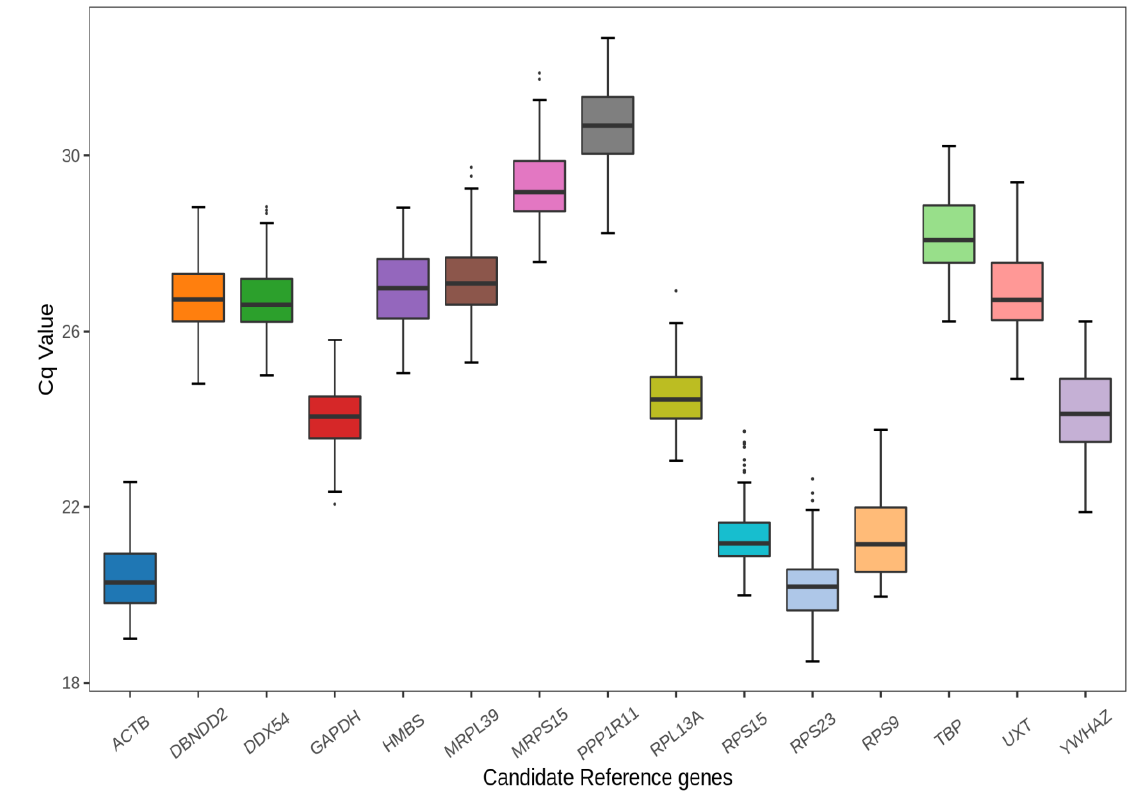
Figure 1. The mean C q values of 15 CRGs in a total of 60 samples of yak stomach including rumen, reticulum, omasum and abomasum at 5 developmental stages. The C q values indicate quantification cycle and are also known as the threshold cycle (C t ). The 75th and 25th percentiles are shown at the top and bottom of each box, respectively. The black line within the box depicts the median. The upper whisker caps represent Q3 + 1.5 × IQR (where Q3 is the third quartile and IQR is the inter-quartile range, or distance between the first and third quartiles) and the lower whisker caps represent Q1 − 1.5 × IQR (where Q1 is the first quartile). The black dots indicate